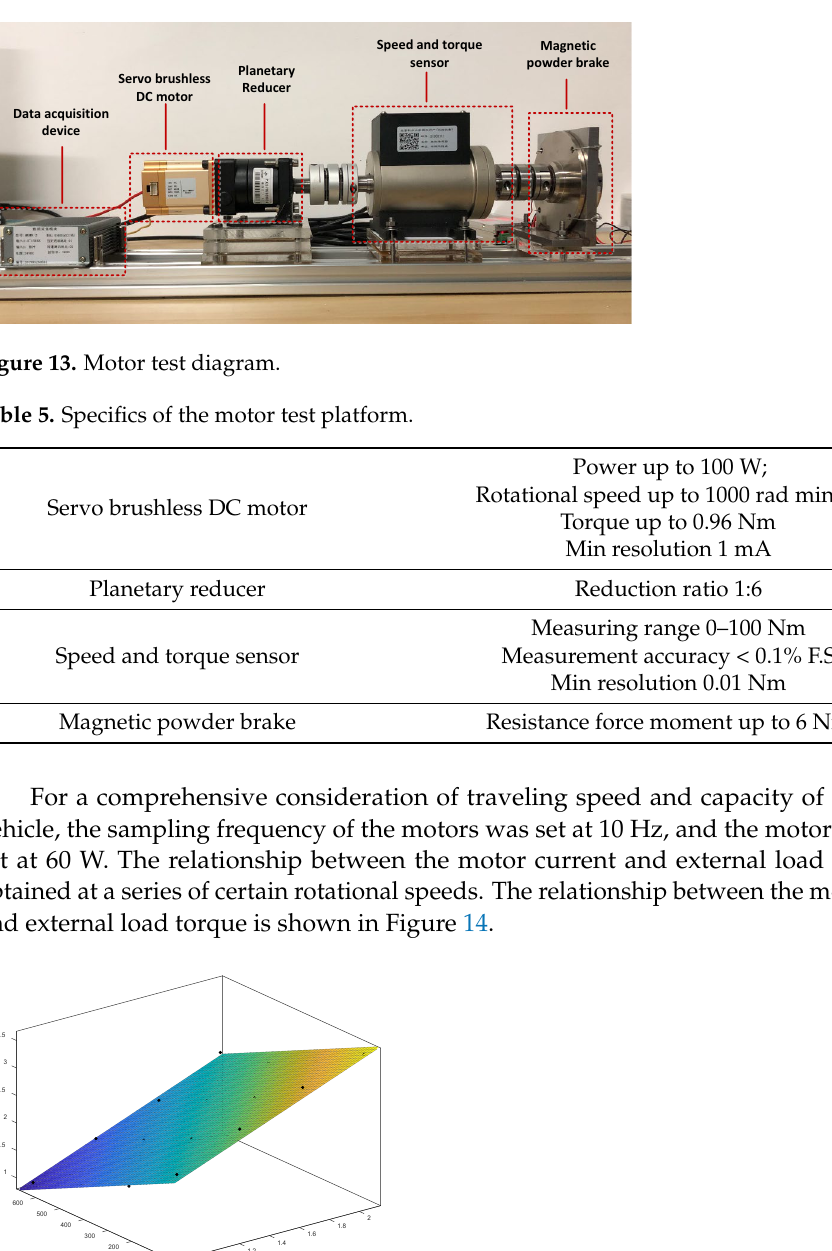
Figure 12. Tracked vehicle travel test on soft soil.